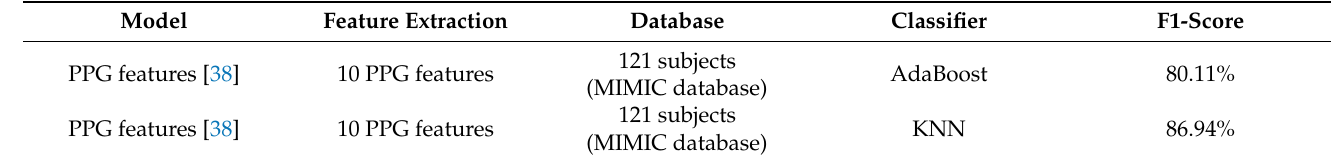
Table 9. Classification performance